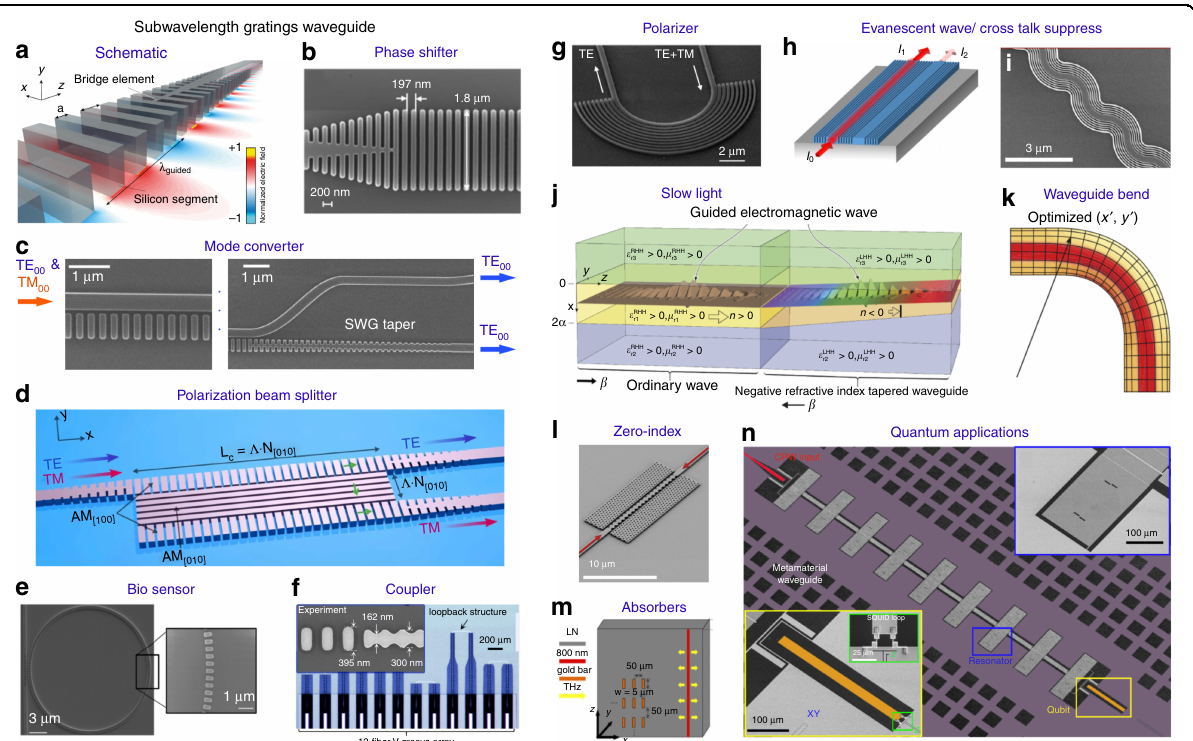
Fig. 4 Forward-designed metamaterial waveguides. a Schematics of a subwavelength grating waveguide 12 . b Nanophotonic phase shifter 56 . c Polarization mode convertor 196 . d Broadband polarization beam splitter 198 . e SWG ring resonator biosensor 90 . f Integrated fi ber-to-chip coupling interfaces. Inset: details of the SWG waveguide coupler 203 . g Ultrabroadband chip-integrated all-silicon polarizer 205 . h , i Silicon metamaterial waveguides for exceptional coupling 55 and evanescent wave suppression 54 . j Left-handed metamaterial waveguiding heterostructures to slow light 131 . k Schematic of waveguide bend transformation 135 . l Integrated zero-index waveguide 216 . m Terahertz band-stop fi ler using a metamaterial slab waveguide 219 . n Metamaterial waveguide for qubits. Insets: SEM images for the capacitive qubit coupler (lower panel) and coupled microwave resonators respectively (upper panel) 225 . Panels adapted from: Springer Nature ( a 12 , i 54 , j 131 , k 135 , n 225 ); OSA ( b 56 , e 90 , g 205 , h 55 , m 219 ); IEEE ( c 196 , f 203 ); Wiley ( d ) 198 ; ACS ( l ) 216